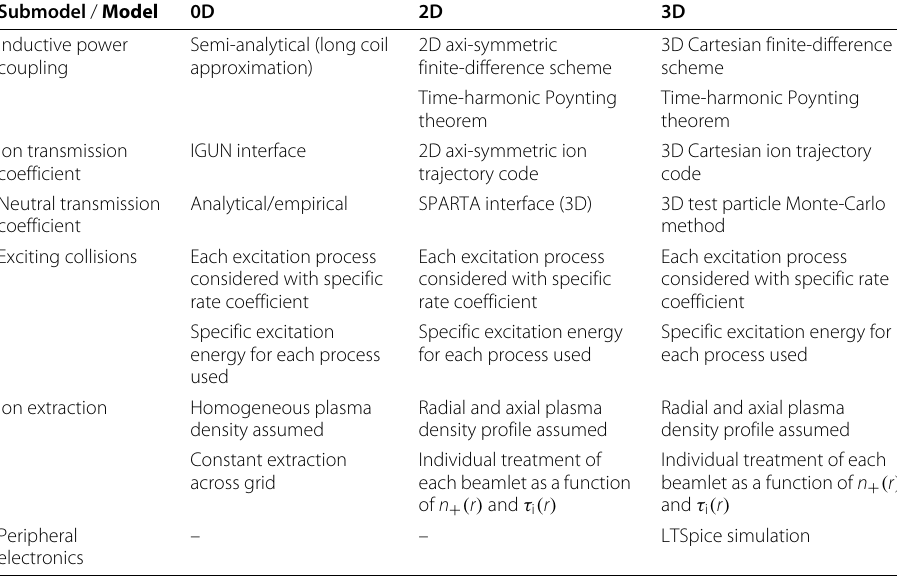
Table 1 Overview of the proposed model Submodel / Model 0D 2D 3D Inductive power